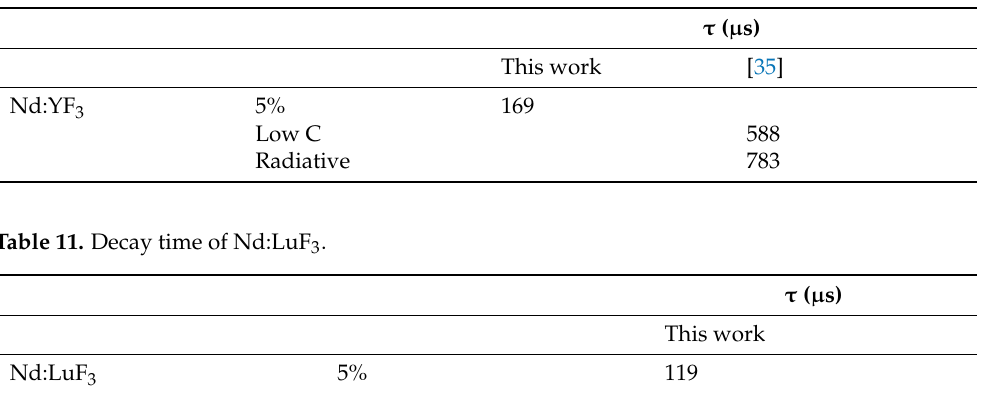
Table 10. Decay time of Nd:YF 3 .